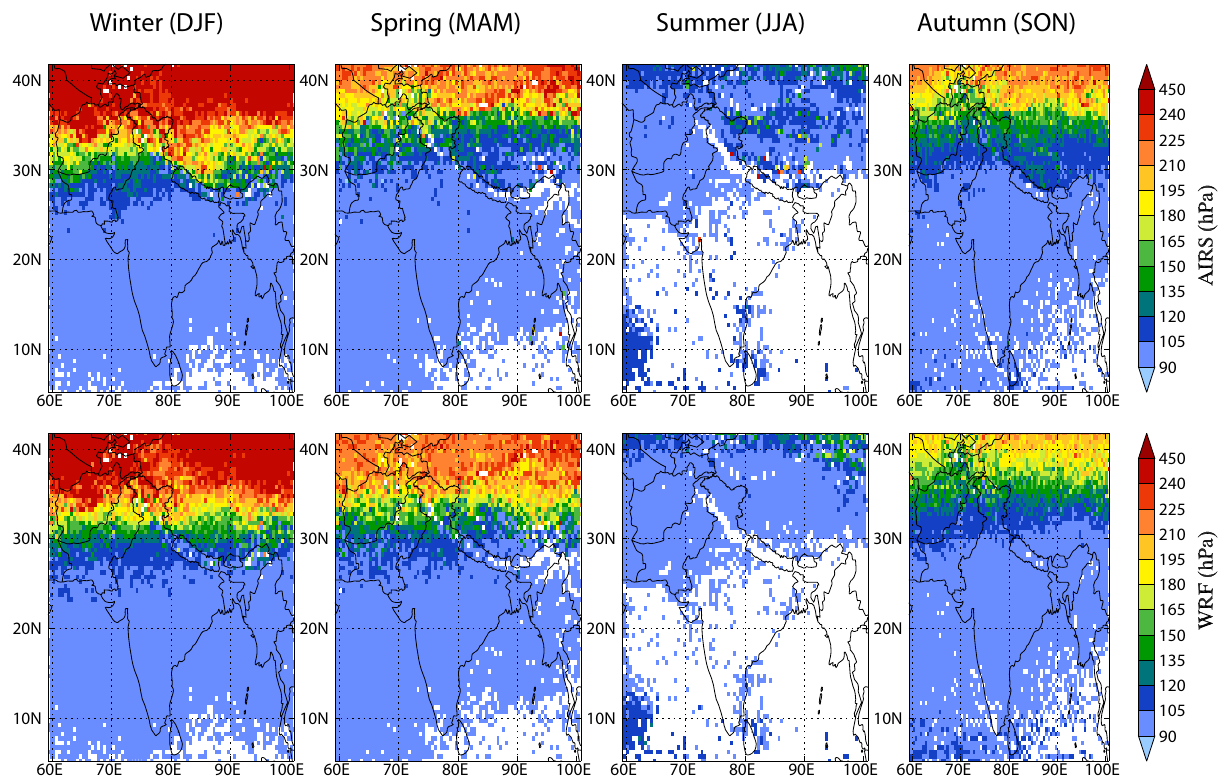
Fig. 13. Spatial distribution of co-located AIRS retrieved (top panel) and model simulated (bottom panel) tropopause pressure during the winter, spring, summer and autumn seasons of the year 2008. Table 8. Annual average and standard deviation in co-located RAOB and WRF-Chem tropopause pressures for the four site categories defined in this study are shown along with mean bias and the root mean square error. All these statistical parameters are also shown for co-located AIRS and WRF-Chem tropopause pressure values. All the values are rounded off to their nearest integer values. Site